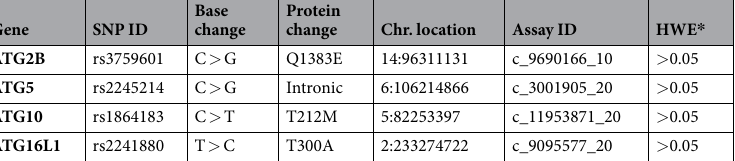
Table 1. Autophagy polymorphisms analysed in the study. * Hardy-Weinberg equilibrium (HWE) calculated in the control group.